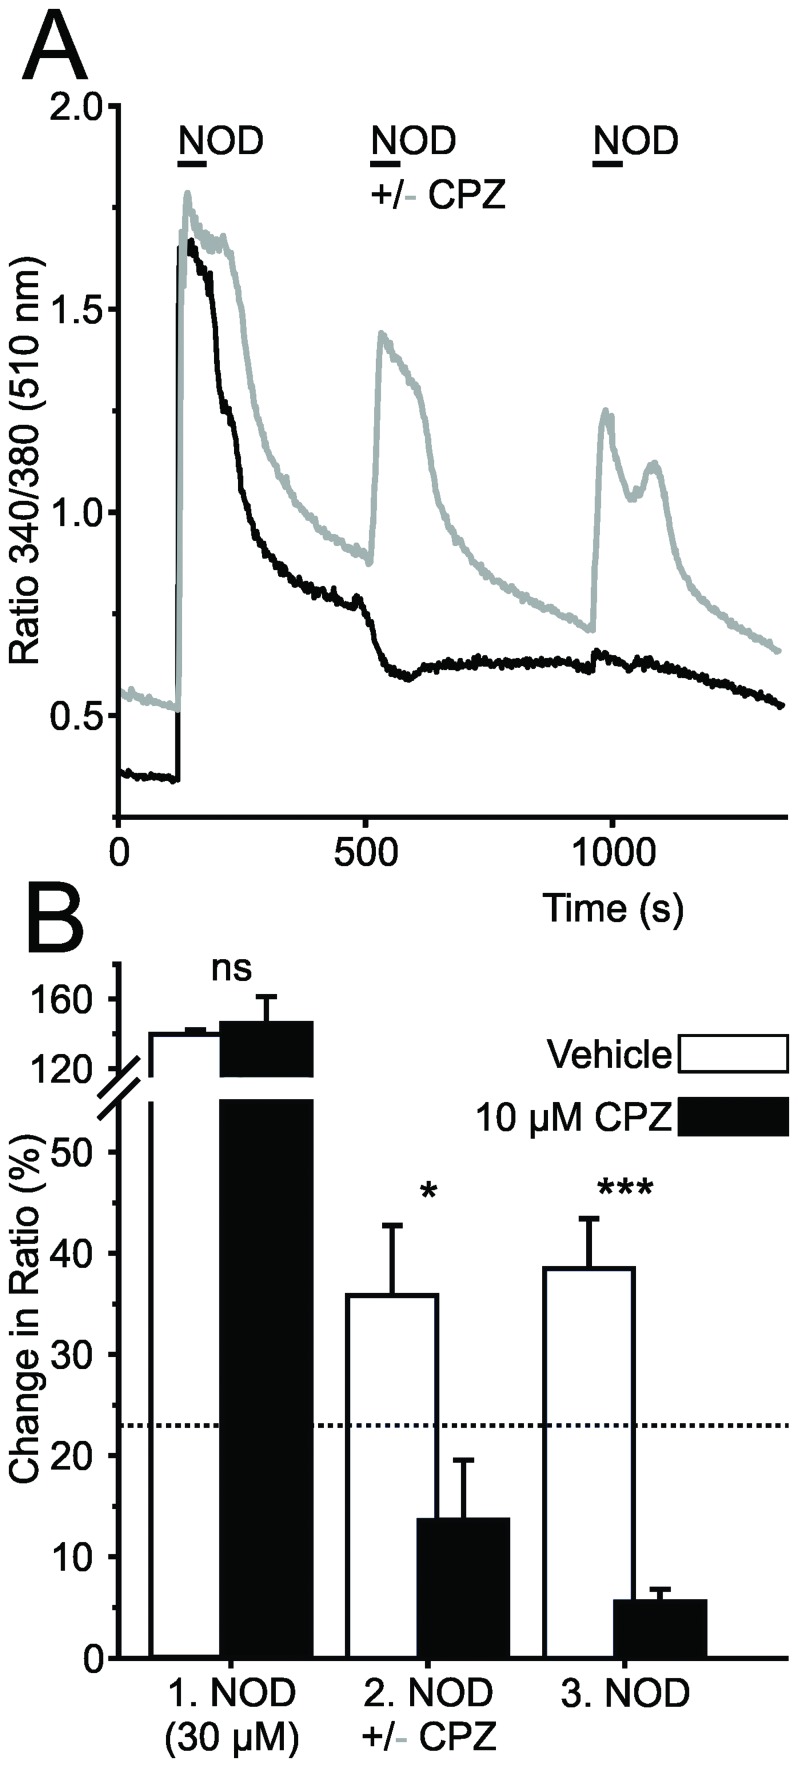
NOD activates TRPV1 in DRG neurons.
A. Increases in free intracellular calcium in response to repetitive application of NOD displayed marked tachyphylaxis from stimulus to stimulus (grey trace). Application of the competitive TRPV1 antagonist capsazepine before and during the 2nd stimulus (CPZ; black trace) abolished the NOD response. B. Mean change in intracellular calcium by NOD in cells challenged with (filled bars; n = 4) and without CPZ during the second stimulus (open bars; n = 5) indicated the specificity of NOD at TRPV1. The threshold for a significant response is indicated by the dotted line (*p<0.05, ***p<0.001 vehicle versus CPZ, student’s unpaired t-test).